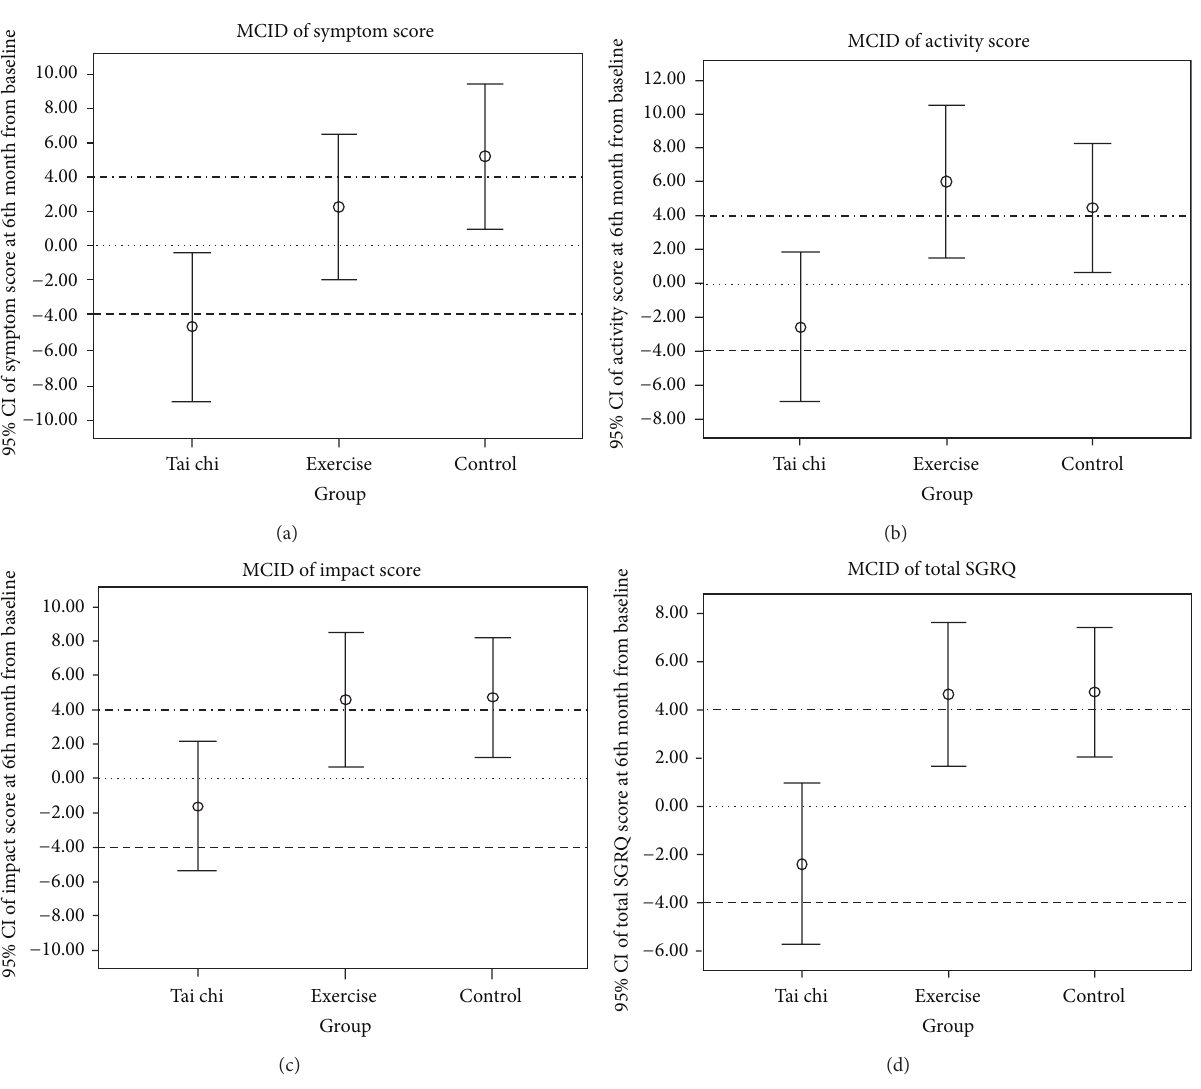
groups to retain participants and minimize attrition.